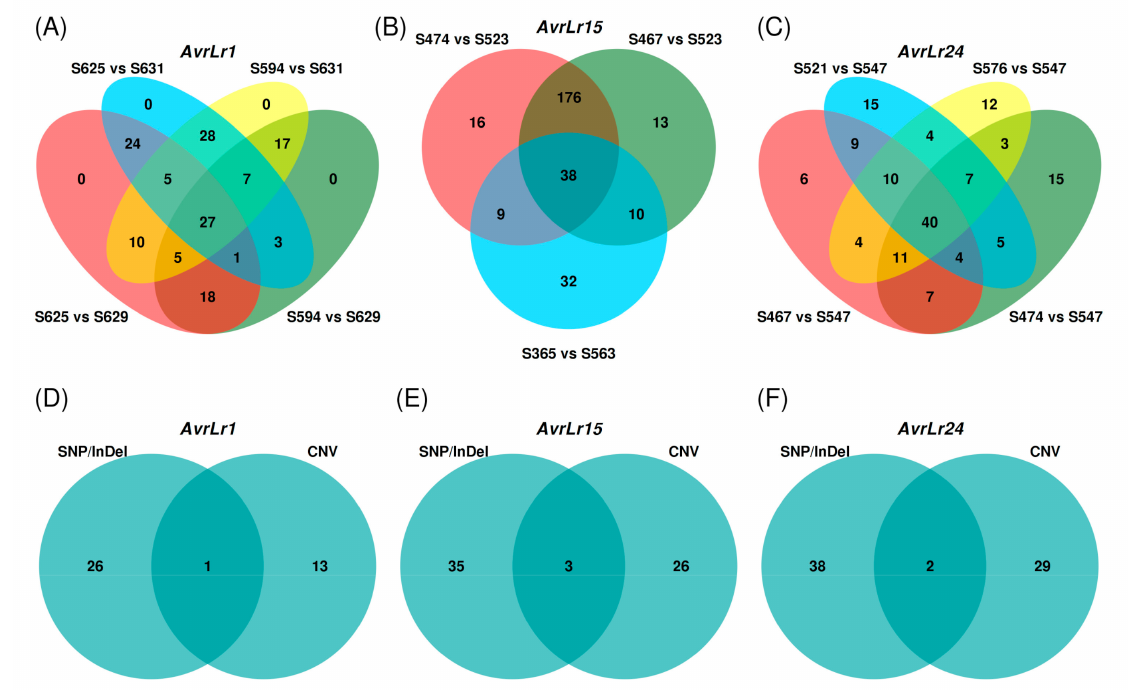
Figure 5. Venn diagrams for candidate avirulence genes identified by SNP / InDel and CNV. ( A – C ) demonstrate the intersection of candidates derived from SNP / InDel multiple pairwise comparisons for AvrLr1 (27), AvrLr15 (38), and AvrLr24 (40), respectively. ( D – F ) demonstrate the final candidates combined from SNP / InDel comparison and CNV detection for AvrLr1 (40), AvrLr15 (64), and AvrLr24 (69),